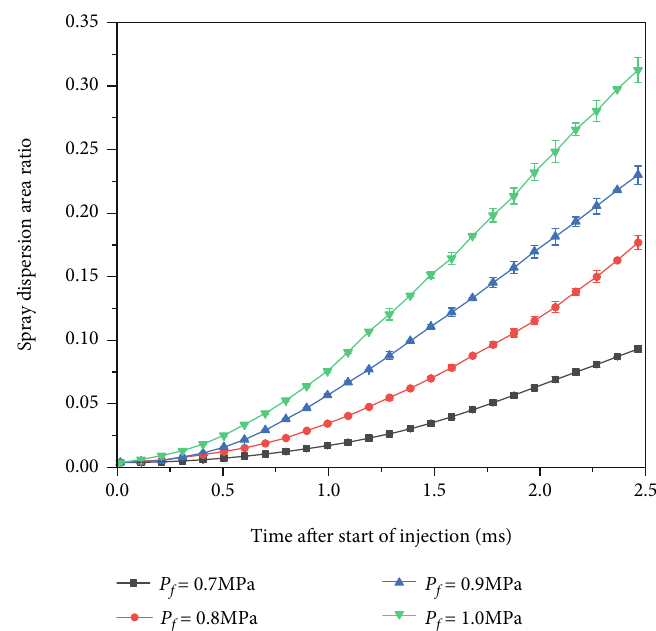
= 298K , Δ T = 4 : 0ms f f